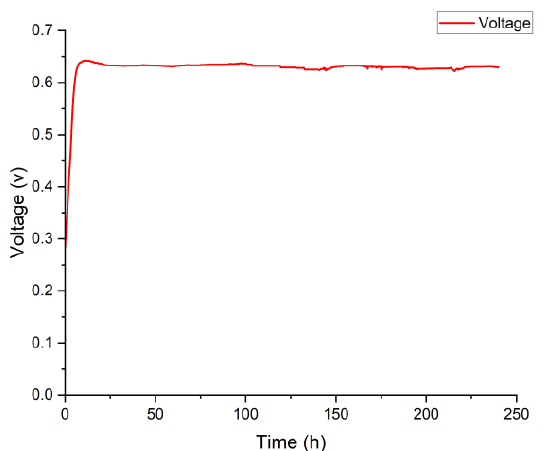
Figure 7. Voltage variation with time obtained by Citrobacter sp. Av_G1.